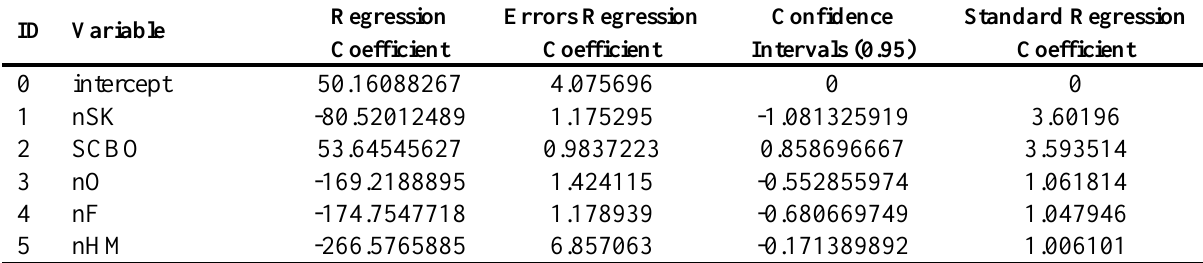
Table 2. The values of the constants of Eq. (2) and their statistical interpretations